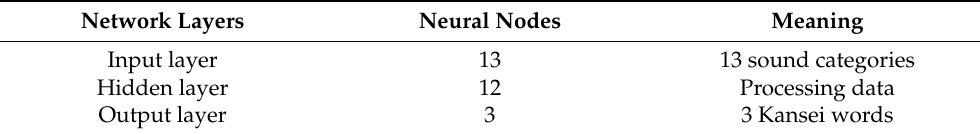
Table 5. Neural nodes and corresponding information at each layer in the